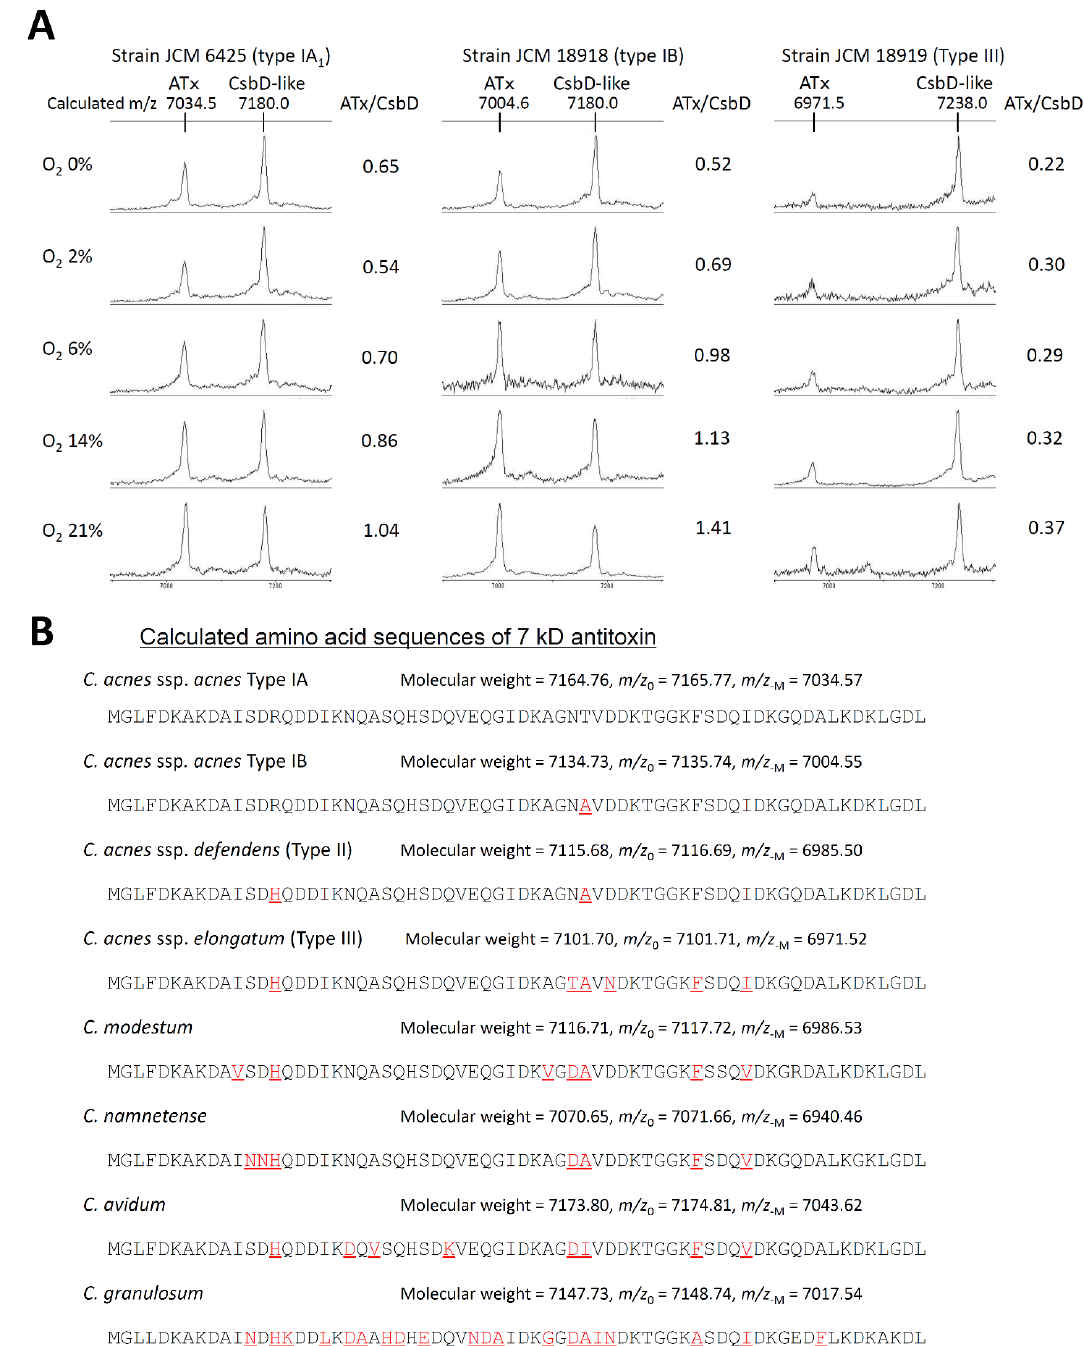
Figure 3. Background data for the MALDI peak assignment. ( A ) 7 kD antitoxin and CsbD-like protein peaks of three Cutibacterium acnes strains cultured under different oxygen pressures. ATx: 7 kD antitoxin, CsbD: CsbD-like protein, ATx/CsbD: peak height ratio of 7 kD antitoxin and CsbD-like protein. Note that ATx/CsbD is higher when oxygen pressure is higher, which indicates the positive relationship between peak height and protein amount. ( B ) Comparison of amino acid sequences of 7 kD antitoxin in Cutibacterium species and subspecies calculated from their genomes. Highlights with red and underlines indicate sequence differences from C. acnes subsp. acnes Type IA. The same calculations were also performed on the other ‘candidate proteins’.